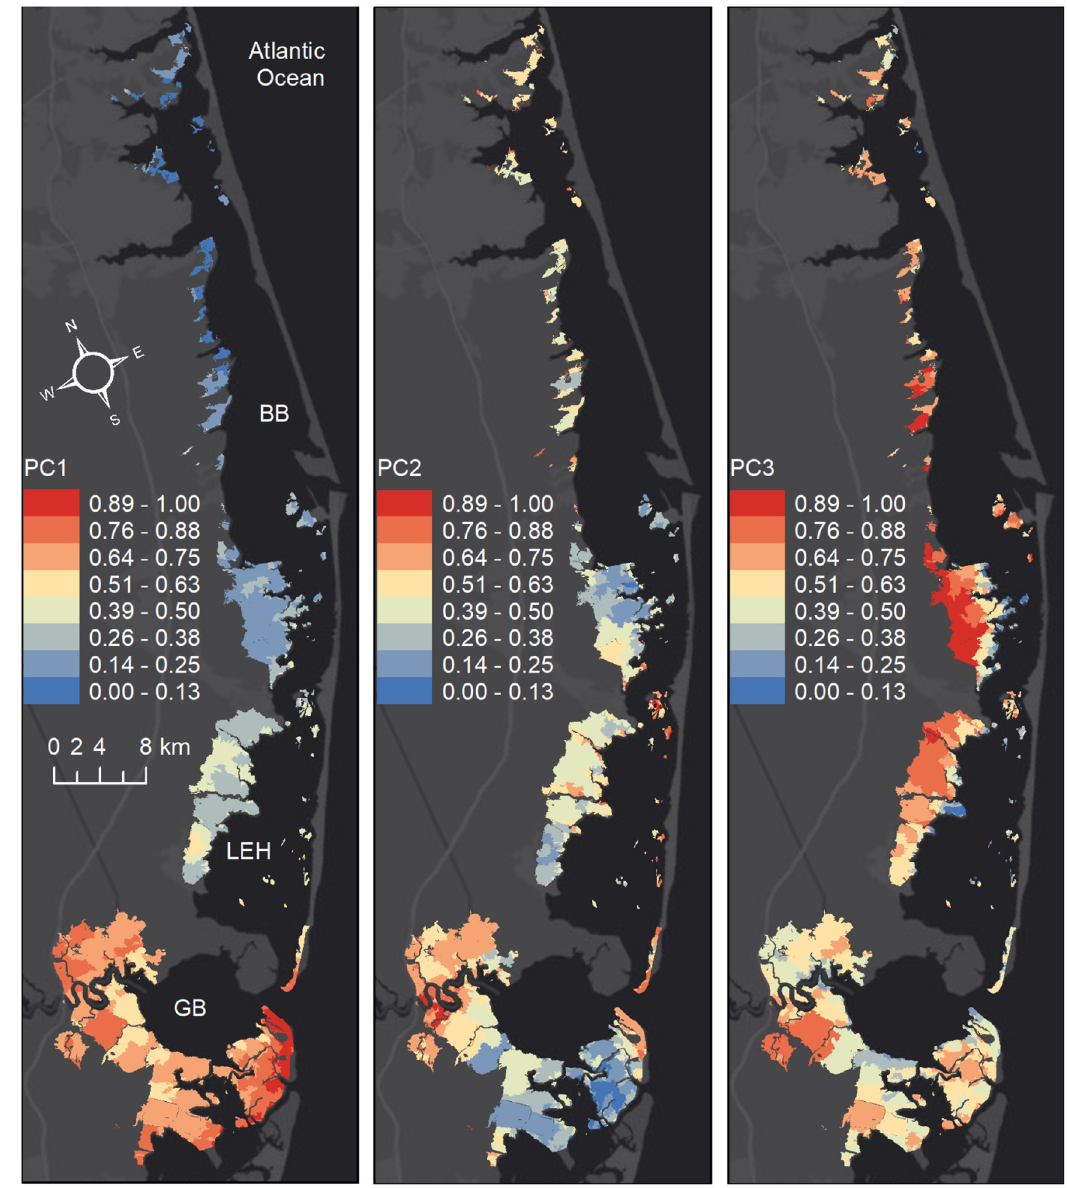
Fig 5. Map of principal components. Spatial distribution of the first three principal components over the entire